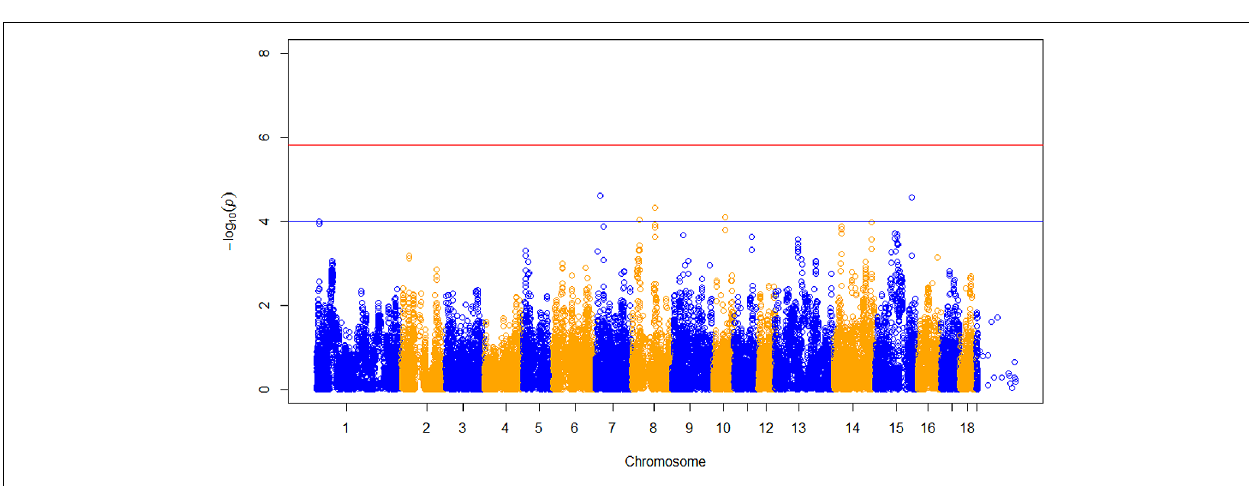
FIGURE 2 | Manhattan plot of genome-wide p of association for RFI 2. The horizontal red and blue line represents the Bonferroni ( p = 1.31e − 06) and genome-wide significance threshold ( p ≤ 1e − 04),